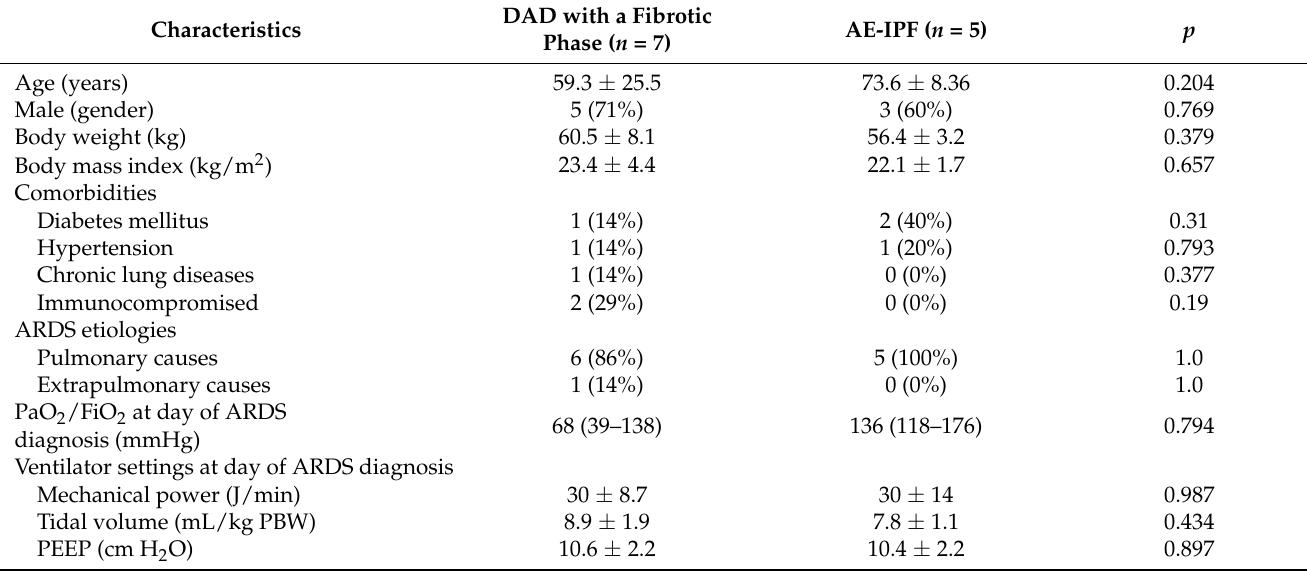
Table 2. Background characteristics and clinical variables: DAD with a fibrotic phase and AE-IPF on histological